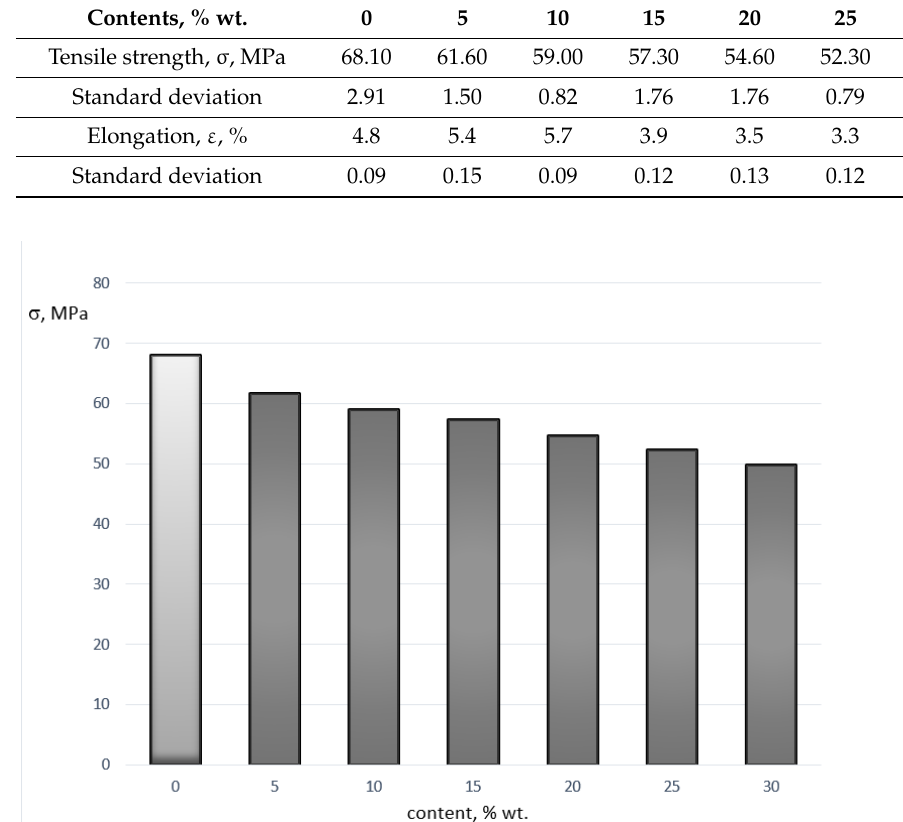
Figure 1. Change in tensile strength depending on the content of the Crusil M20 filler.